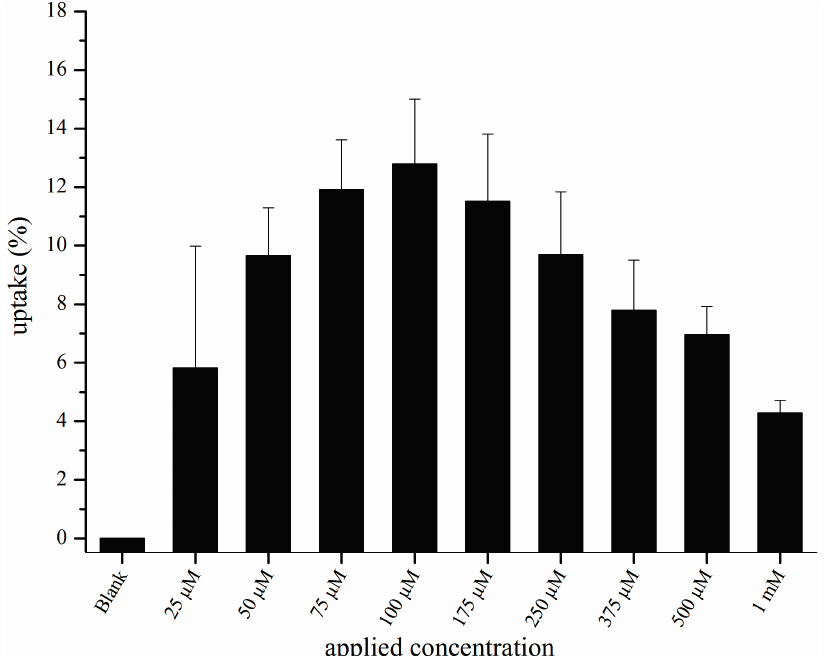
Figure 2. Percentage of taken up liposomes after incubation with cBSA-liposomes for 2 h. Values are the means of 3 separate experiments ± standard deviation ( n = 8,